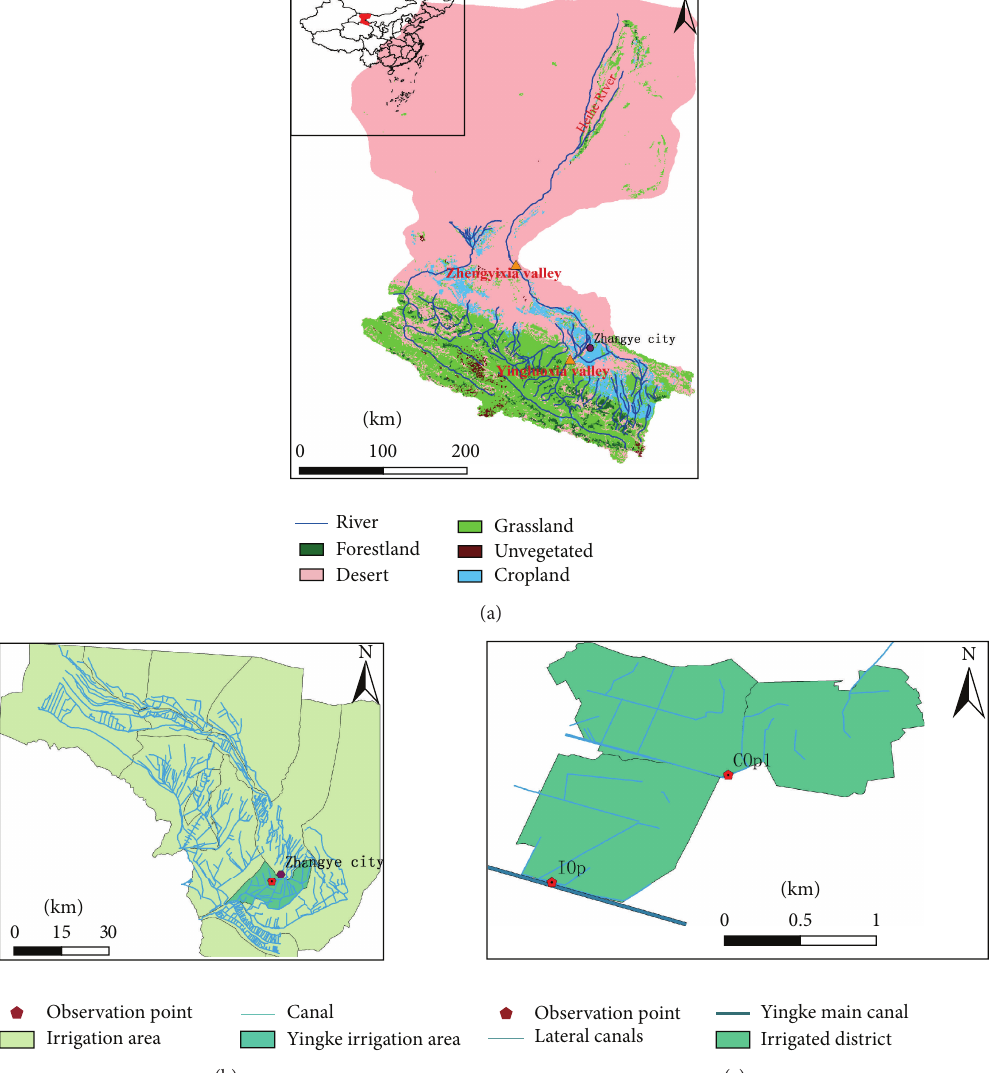
Figure 1: The basin of the Heihe River and the study area in the middle reaches of the river near Zhangye City.